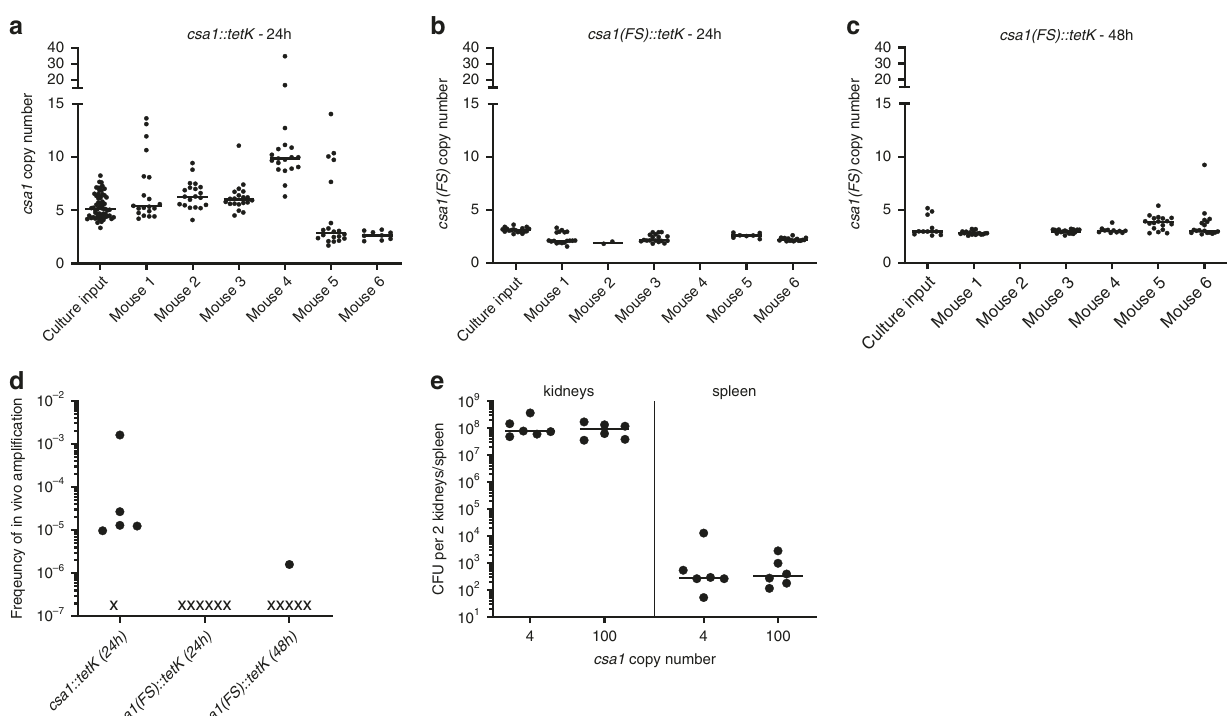
Fig. 7 Copy number diversi fi cation in vivo. a – c Six-week old female C57BL/6 mice were challenged with S. aureus live bacteria that carried either a functional csa1::tetK locus ( a ) or an inactivated csa1(FS)::tetK locus ( b , c ). Mice were sacri fi ced 24 h or 48 h post infection as indicated. High Tc resistant clones arising from the input culture and from mouse kidneys were enumerated and csa1 ( a ) or csa1(FS) ( b , c ) gene copy number was determined. Horizontal lines show the median. Up to 19 arising clones were screened. No Tc 20 resistant clones were recovered from mouse 4 and mouse 2 in ( b ) and ( c ), respectively. Source data are provided as a Source Data fi le. d Frequency of ampli fi cation in mouse organs. qPCR analysis was used to calculate the frequency of ampli fi cation within each mouse (number of Tc 20 -resistant clones that showed at least a 2 fold increase in csa1 or csa1(FS) copy number compared to the parental strain within the total population of living cells recovered from each mouse) (dark- fi lled dots). x indicates a mouse in which ampli fi cation was not detected. Six mice were used in each group. Source data are provided as a Source Data fi le. e C57BL/6 mice were infected either with a low copy number variant (~4 copies) or a high copy number variant (~100 copies) of csa1 genes. Mice were sacri fi ced 72 h post infection and CFUs within the kidneys and spleen were enumerated. Horizontal lines show the median. Statistical analysis was performed using two-tailed Mann – Whitney test, but no signi fi cant differences were found. Six mice were used in each group. Source data are provided as a Source Data fi